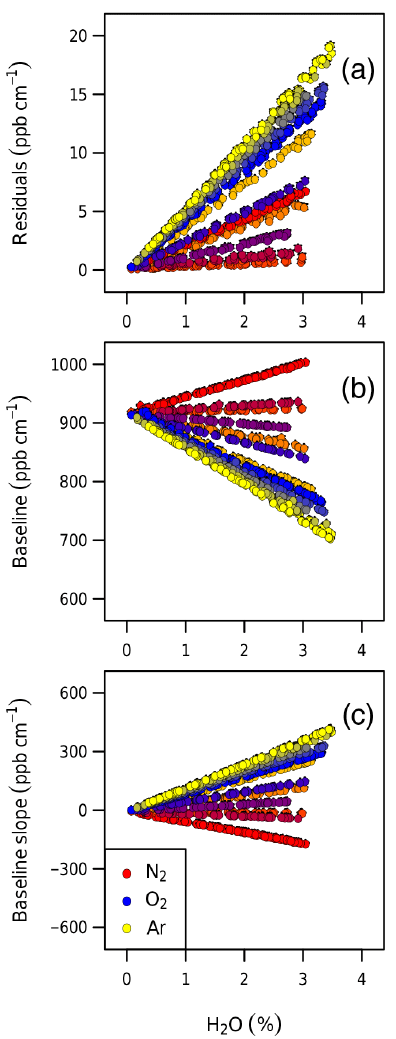
Figure 10. Relationships between H 2 O mixing ratio and the spec- tral residuals, baseline, and baseline slope parameters. For each panel, n = 990 measurements of four liquid standards across a range of injection volumes (i.e., 400–2400nL, in 11 steps of 200nL each). Points represent mean values ± SD for replicates of each standard at each injection volume.